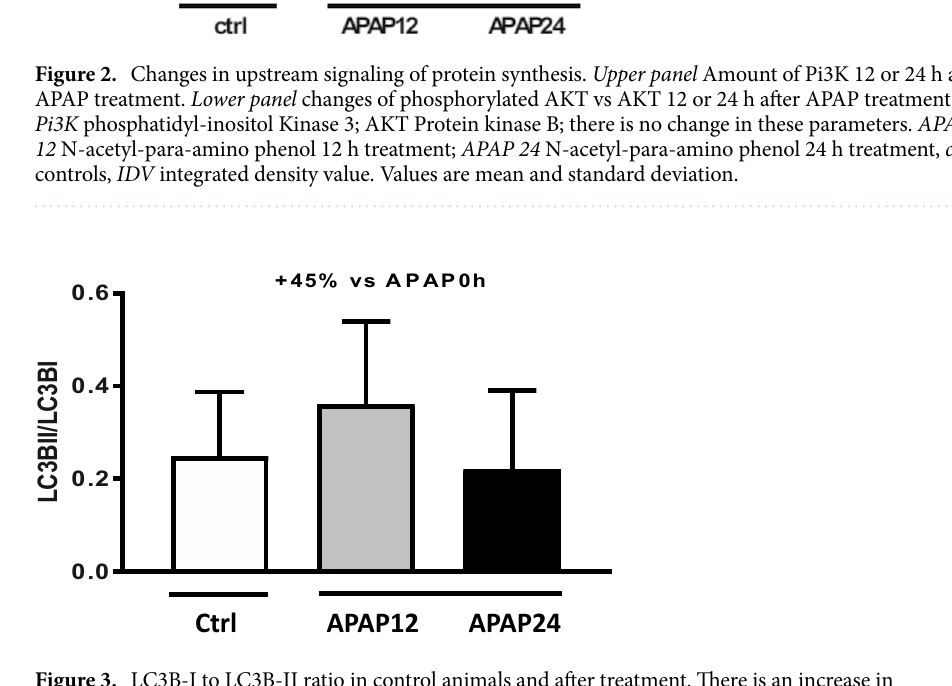
Figure 3. LC3B-I to LC3B-II ratio in control animals and after treatment. There is an increase in autophagosome formation after 12 h, but this increase fails to reach statistical significance. APAP 12 N-acetyl- para-amino phenol 12 h treatment, APAP 24 N-acetyl-para-amino phenol 24 h treatment, ctrl controls; Values are mean and standard